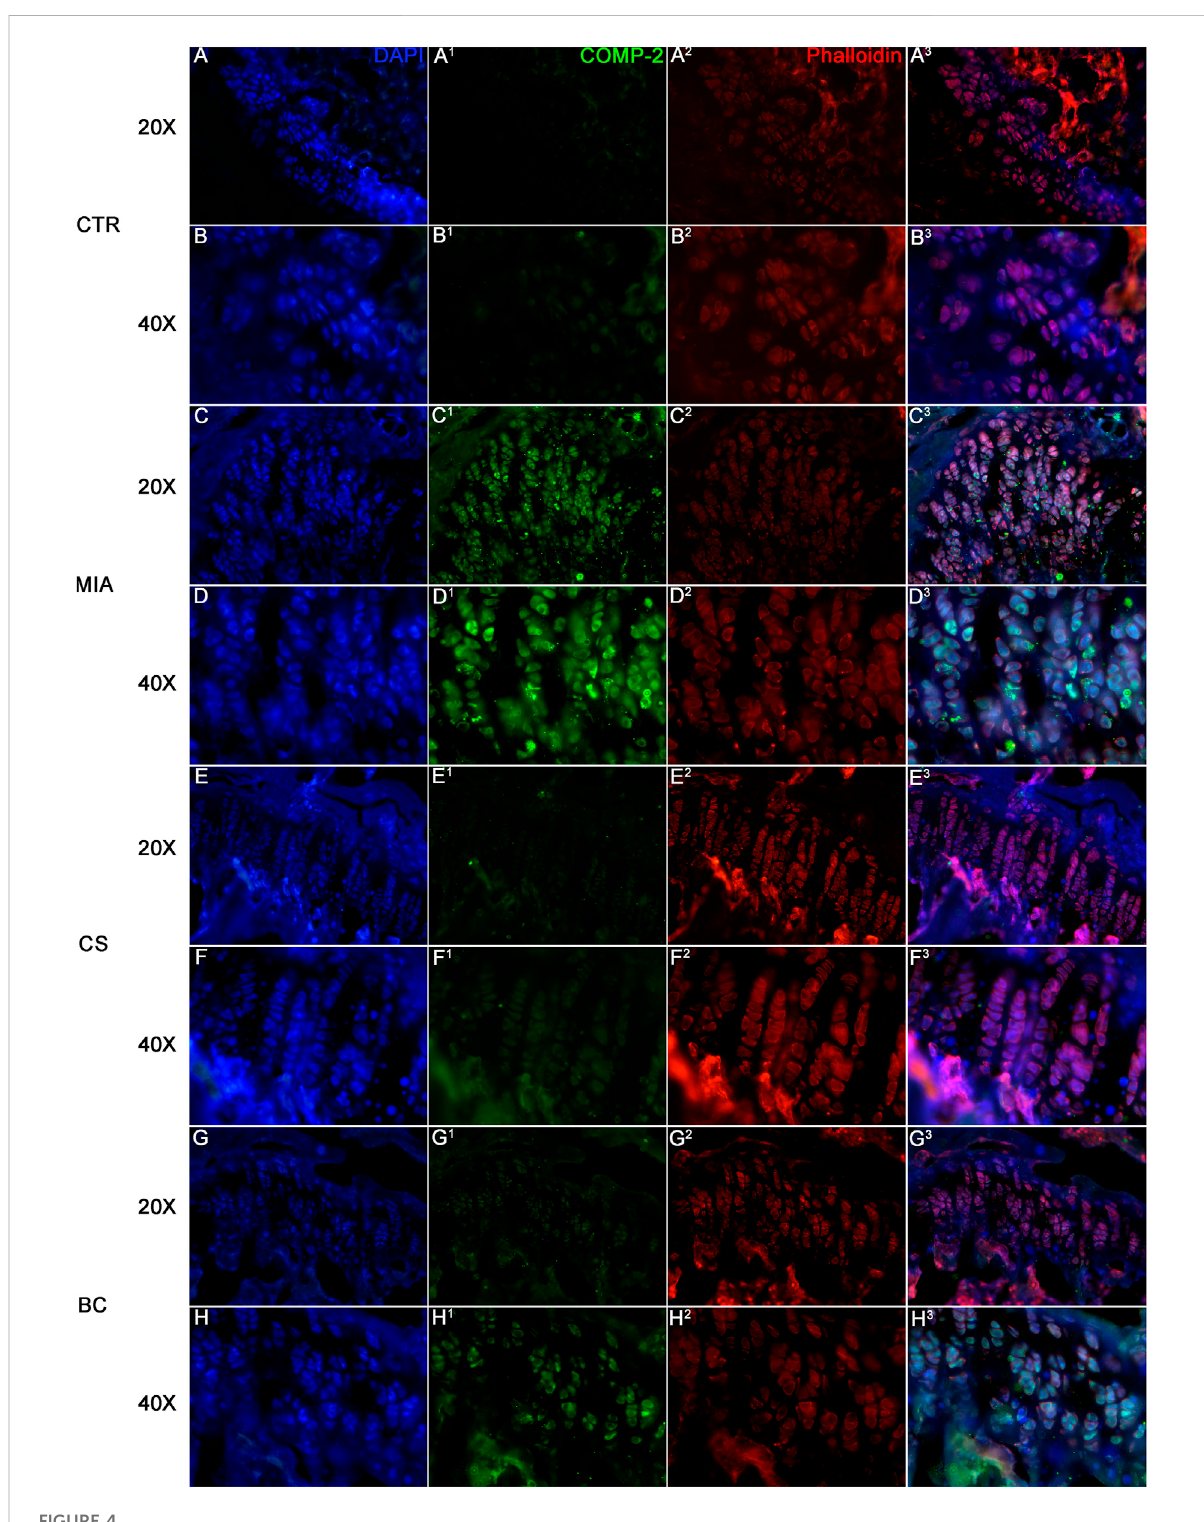
FIGURE 4 Immuno fl uorescence on tissue sections from mice knee joints. Sections were stained with DAPI for nuclei, phalloidin for cytoskeleton, and COMP. CTR is represented in fi gure (A) (20× magni fi cation) and (B) (40× magni fi cation), MIA in fi gure (C) (20× magni fi cation) and (D) (40× magni fi cation), CS in fi gure (E) (20× magni fi cation) and (F) (40× magni fi cation), and BC in fi gure (G) (20× magni fi cation) and (H) (40×magni fi cation).TheexpressionofCOMPisamarkerofcartilageturnover.TheimagesshowhowCOMPisexpressedinMIAgroupsofmice while it is almost absent in BC and CS